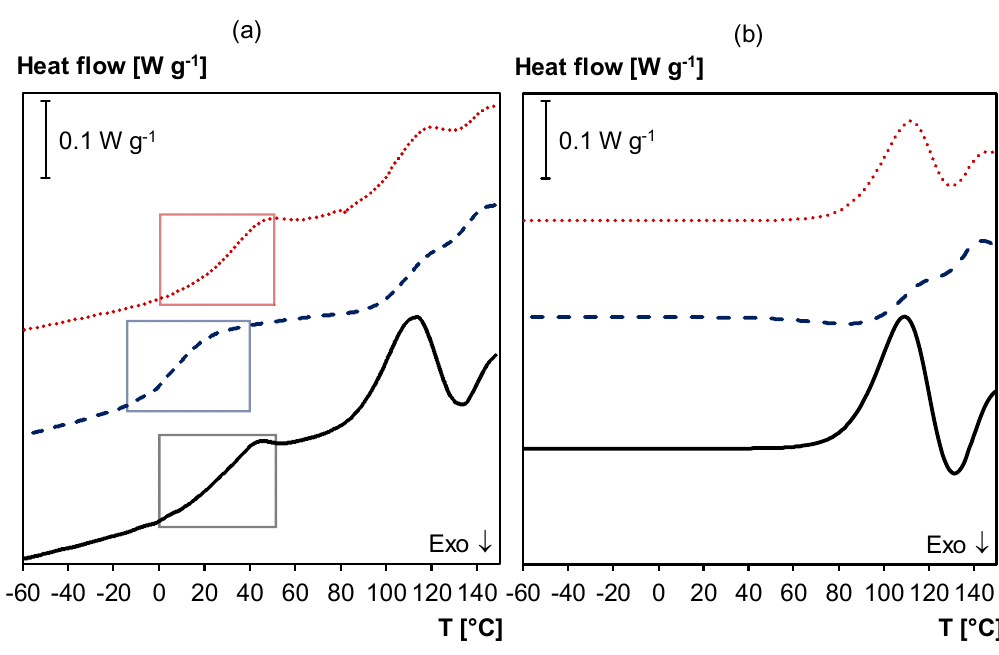
Figure 11. ( a ) DSC thermogram of 3M ‐ F375PMA. Full black line : first heating; Dashed blue line : second heating (immediately after first heating); Dotted red line : third heating (after seven days at 20 °C). Frames indicate T g region. ( b ) Simulated normalized heat flows of first, second and third heating (without T g ), showing effect of ongoing Diels–Alder reactions, using the kinetic parameters of [40]. Curves vertically shifted for clarity.